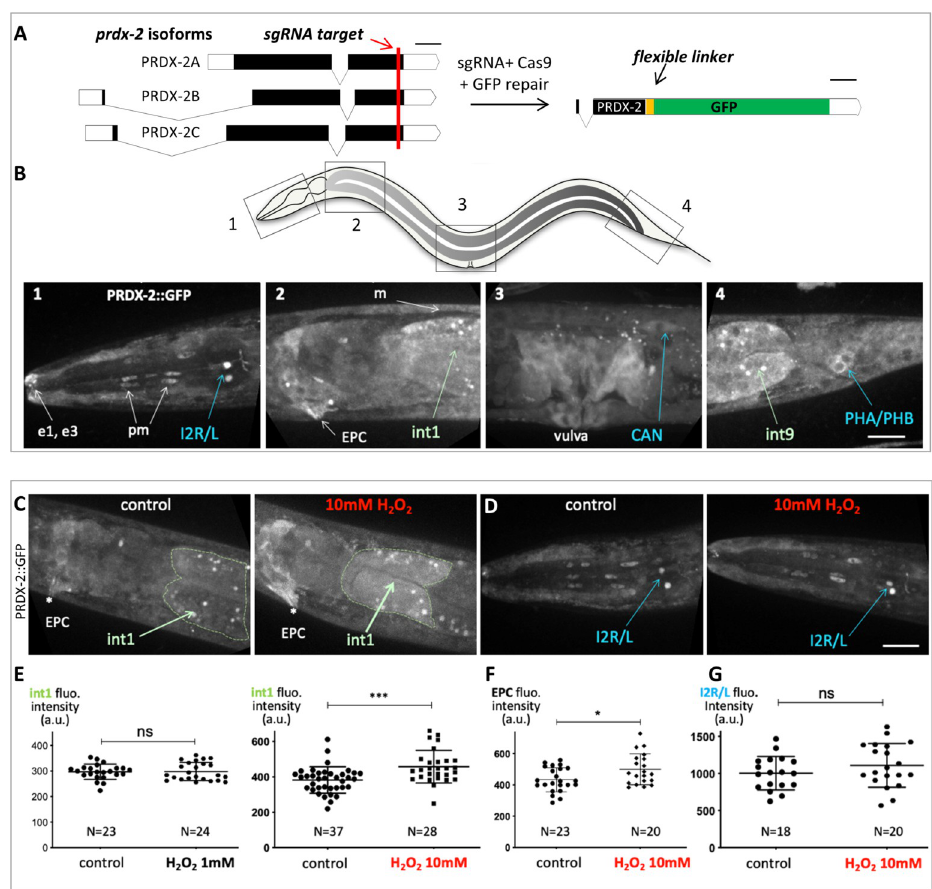
Fig 1. PRDX-2::GFP knock-in line expression pattern and its variation upon H 2 O 2 treatment. (A) Sketch depicting the PRDX-2::GFP knock-in strategy using CRISPR Cas9-mediated genome editing. The sgRNA target sequence (shown in red) was chosen upstream PRDX-2 STOP codon, to tag all prdx-2 isoforms. Black boxes indicate exons, white boxes untranslated regions. Bar, 100 bases pairs. The resulting last exon of the PRDX-2::GFP fusion protein is shown (right); note the insertion of a flexible linker between PRDX-2 and the GFP, to promote correct folding. After injection, three independent knock-in lines were recovered, sharing the same expression pattern. (B) Spinning-disc confocal projections of a representative PRDX-2::GFP knock-in animal, in 4 body regions (boxed in the worm sketch on top). PRDX-2::GFP expression is observed in the tip of the nose (e1, e3 epithelial cells), in pharyngeal muscle cells (pm), in body wall muscles (m), in the excretory pore cell (EPC), in proximal and distal gut cells (int1 and int9), and in several neuron pairs (I2, CAN, PHA/PHB). Note the different level of PRDX-2::GFP in I2 left and right neurons in panel B1. (C-G) An acute oxidative stress triggers an upregulation of PRDX-2 in the anterior gut, but not in neurons. (C-D) Spinning-disc confocal projections of control or H 2 O 2 -treated animals in the anterior gut (C) or in the head (D). (E-G) Quantification of fluorescence intensity in controls and in H 2 O 2 -treated animals in the int1 cell (E), in the EPC (F), and I2 neurons (G). Bars indicate mean and SD. ns, not significant, p > 0.05; � p < 0.05; ��� p < 0.001 (t test and Mann Whitney test). Scale bar, 20 μ